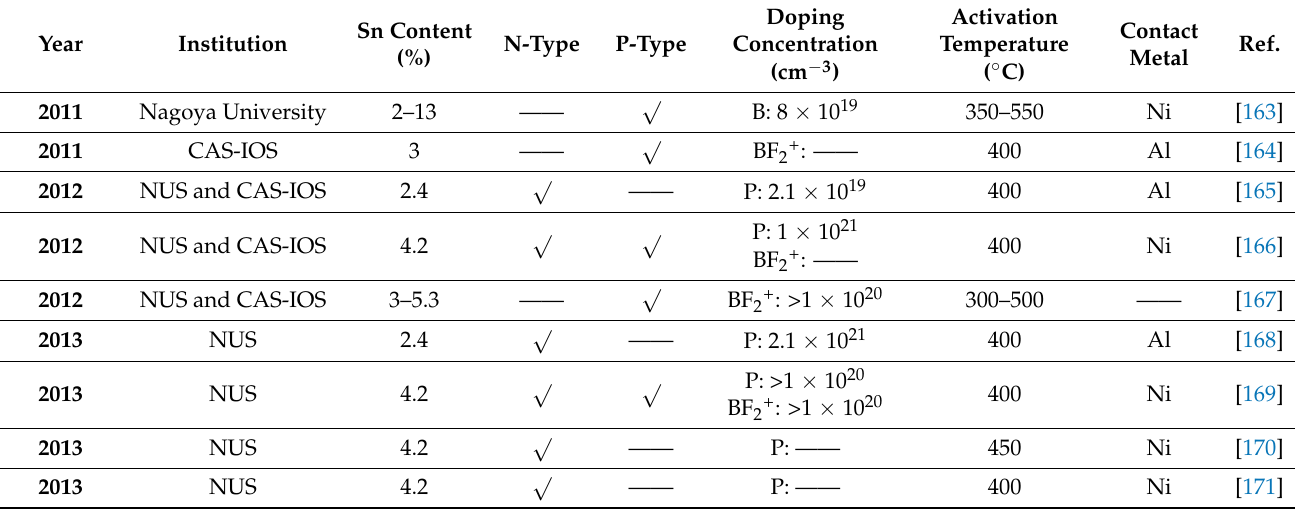
Table 1. Summary of reported B, BF 2+ , and P-doped GeSn via ion implantation in terms of year, institution, Sn content, doping type, doping concentration, activation temperature, and contact